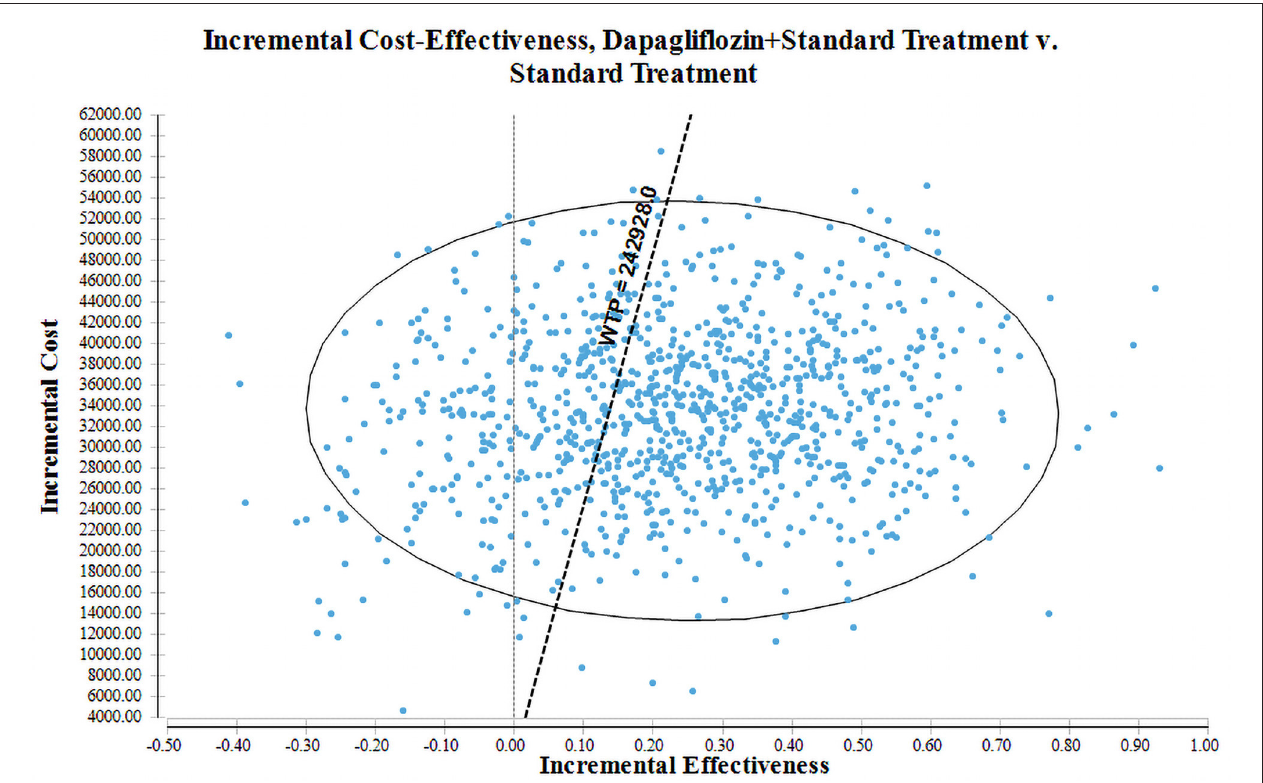
FIGURE 5 | Cost-effectiveness scatter plot for dapagliflozin plus standard treatment vs. standard